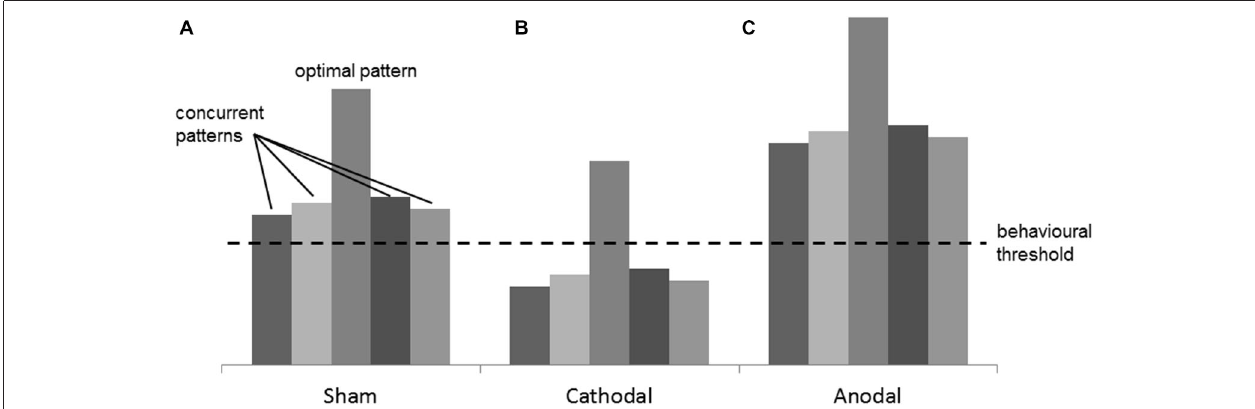
FIGURE 6 | Figure adapted from Antal et al. (2004). Example of the mechanism of interaction between tDCS and the cortical excitability. (A) in the Sham condition, many concurrent neuronal patterns, together with the optimal one, are simultaneously activated producing a “noisy” activation state. (B) in the Cathodal condition, the cortical excitability is globally decreased and the optimal pattern is the only one still above threshold, thus a focus effect is present. (C) in the Anodal condition, the global excitation of the concurrent patterns does not produce any change in the behavior because the “noise” is not